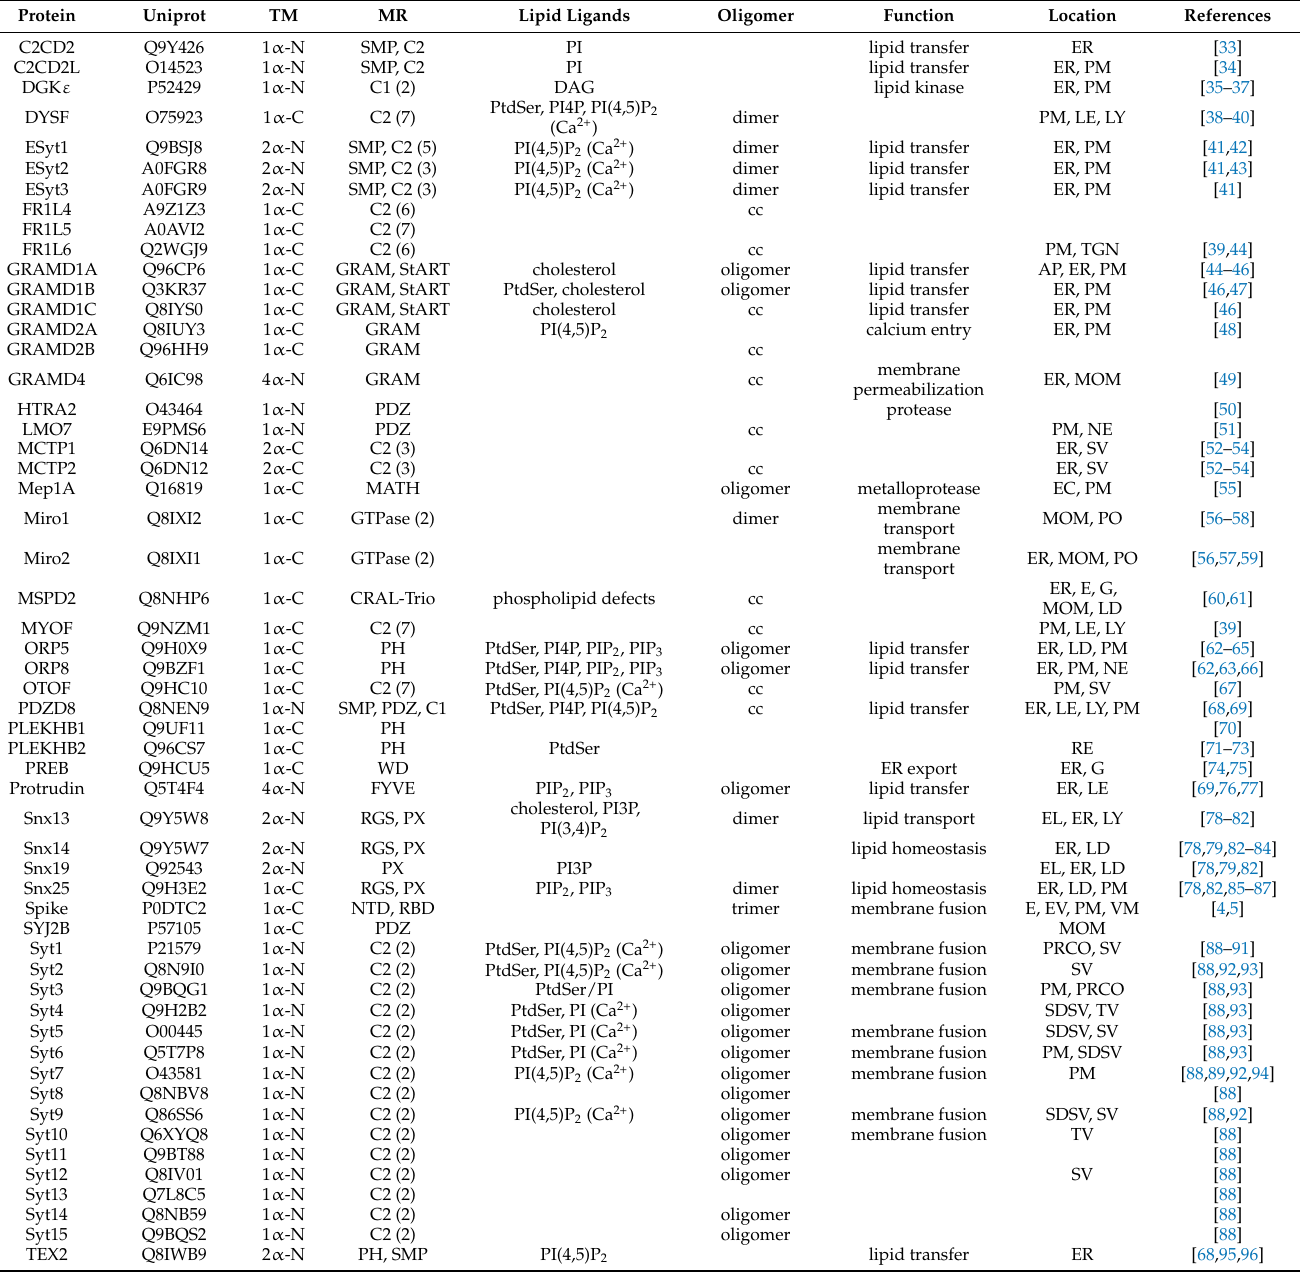
Table 1. Human proteins containing both membrane reader domains and TM helices. The number and N- or C-terminal position of TM helices are indicated as are the names of membrane reader (MR) domains. Additionally, indicated are the known lipid ligands, oligomeric state or, if unknown, the presence of a coiled coil (cc). Cellular functions and locations are stated, including AP, autophagosome; EC, extracellular; EL, endolysosome; E, endosome; ER, endoplasmic reticulum; G, Golgi; LD, lipid droplet; LE, late endosome; LY, lysosome; MOM, mitochondrial outer membrane; NE, nuclear envelop; PM, plasma membrane; PO, peroxisome; PRCO, postsynaptic receptor-containing organelle; RE, recycling endosome; SDCV, secretory/large dense core vesicle; SV, secretory vesicle; TGN, trans-Golgi network; TV, trafficking vesicle; VM, viral membrane, along with relevant